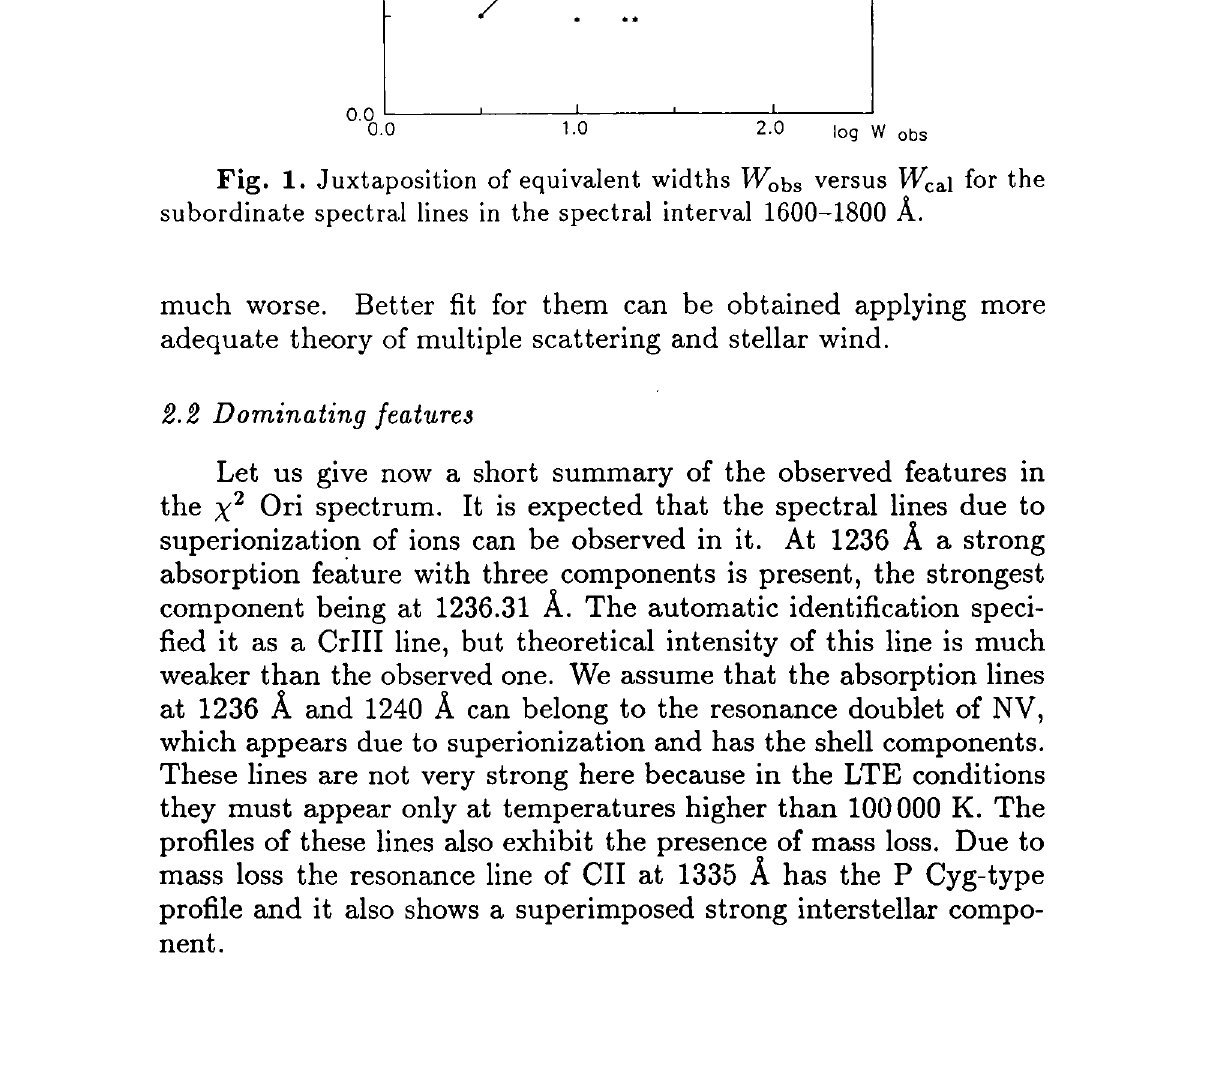
Fig. 1. Juxtaposition of equivalent widths Wobs versus Weal for the subordinate spectral lines in the spectral interval 1600-1800